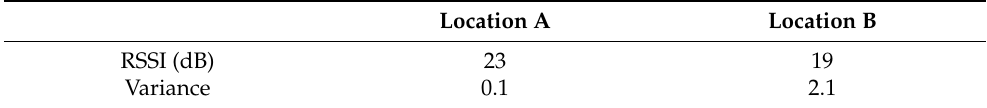
Table 1. Comparison of the RSSI and variance at different locations. Location A Location B